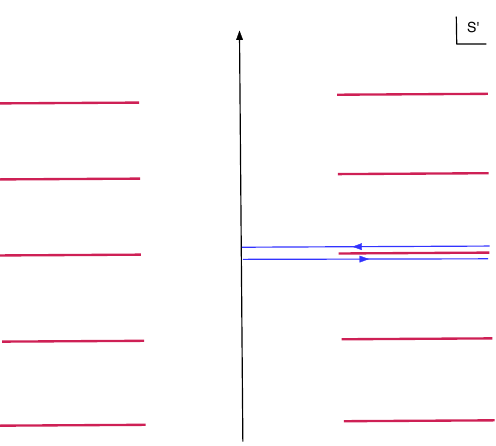
0 = s B (cid:0) s plane. The red lines are branch-buts.